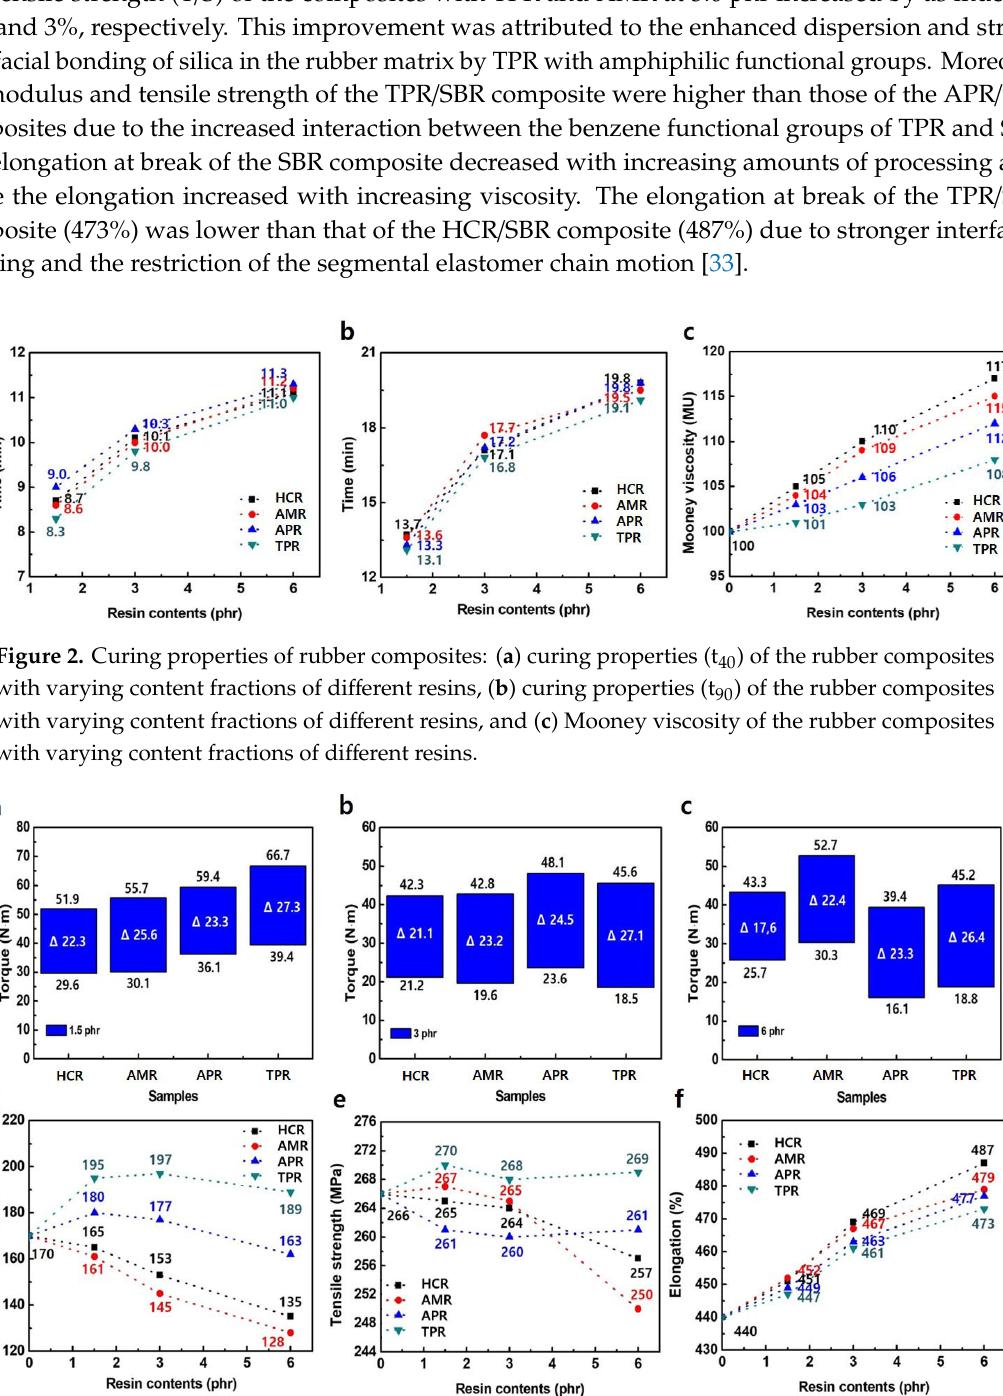
Figure 3. Mechanical properties of the rubber composites: ( a ) torque of the rubber composites with different resins at 1.5 phr, ( b ) torque of the rubber composites with different resins at 3.0 phr, ( c ) torque of the rubber composites with different resins at 6.0 phr, ( d ) elastic modulus of the rubber composites with varying content fractions of different resins, ( e ) tensile strength of the rubber composites with varying content fractions of different resins, and ( f ) elongation of the rubber composites with varying content fractions of different resins.